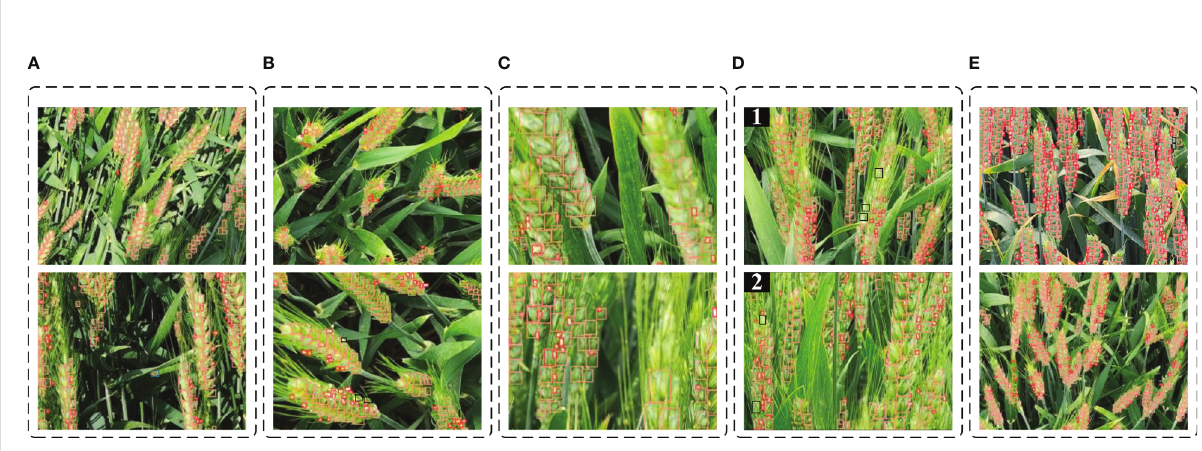
FIGURE 12 Detection effect of improved YOLOv5s model in different complex situations (The pink and dark red boxes represent true positive; black boxes represent false negative; blue boxes represent false positive). (A) strong light. (B) angle distortion. (C) blurred target area. (D) severe occlusion. (E) population phenotype